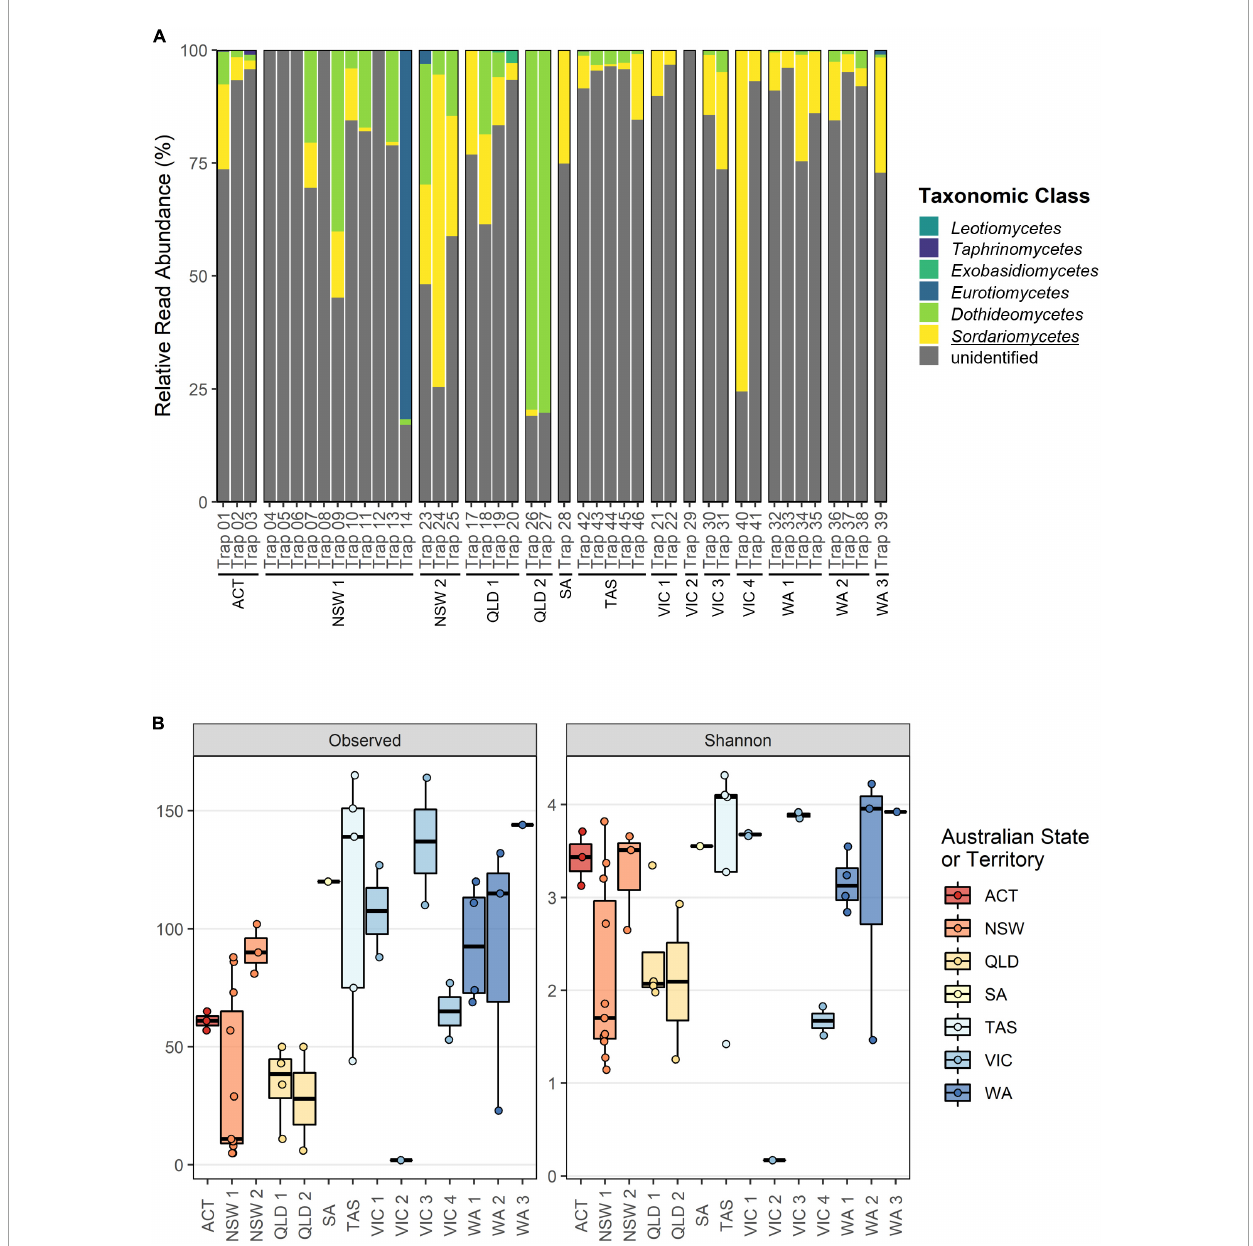
FIGURE3 Overview of fungal class composition and alpha diversity metrics for the TEF1 α dataset separated according to collection batch. (A) Relative read abundance (RRA) at taxonomic class rank. All ASVs have been agglomerated at the class rank, with all unclassified reads grouped as “unidentified.” The class wherein the targeted Ophiostomatales reside is underlined. (B) Observed richness and Shannon diversity metrics with batches colored according to Australian State or Territory.